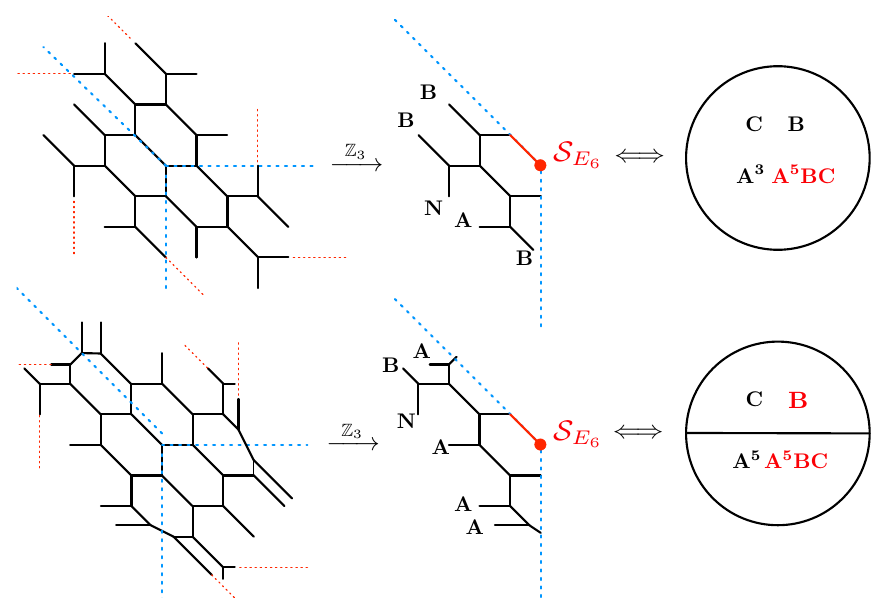
Figure 29 . The Z 3 quotient of b T 3 and b T 4 theories, giving rise to SU(2) + 8 F and SU(3) 0 + 10 F